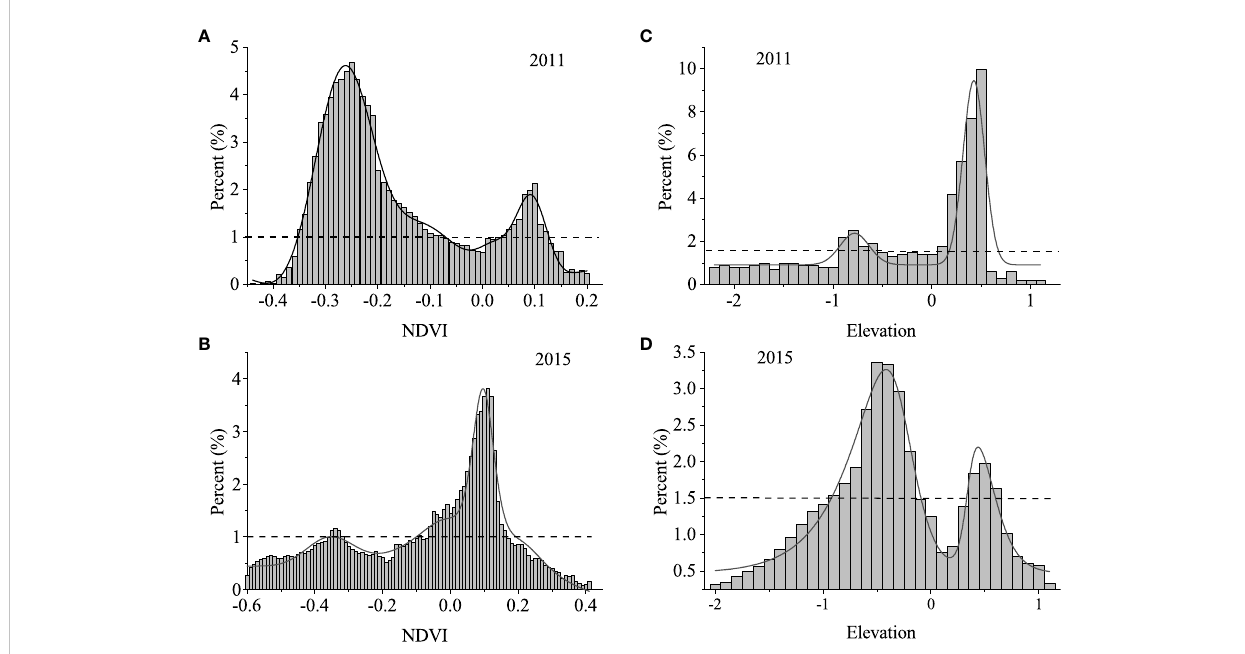
FIGURE 5 Bimodal frequency distribution of normalized difference vegetation index (NDVI) values and intertidal elevation values in 2011 (A, C) and 2015 (B, D) respectively. The elevation is relative to the mean high water level (MHWL). The proportion on the y-axis is computed as the number of pixels in each NDVI class (every 0.01) or relative elevation class (every 0.1 m) to the total number of pixels involved. The proportion of each NDVI class or elevation class was represented by the bar graph, the curve showed the multi-peak fi tting of the proportion. The threshold proportion of NDVI and elevation are 1% and 1.5% (Wang C, et al., 2020), shown in the fi gure with horizontal black dashed lines. The corresponding instability ranges are from -0.07 to 0.03 and from -0.5 to 0,